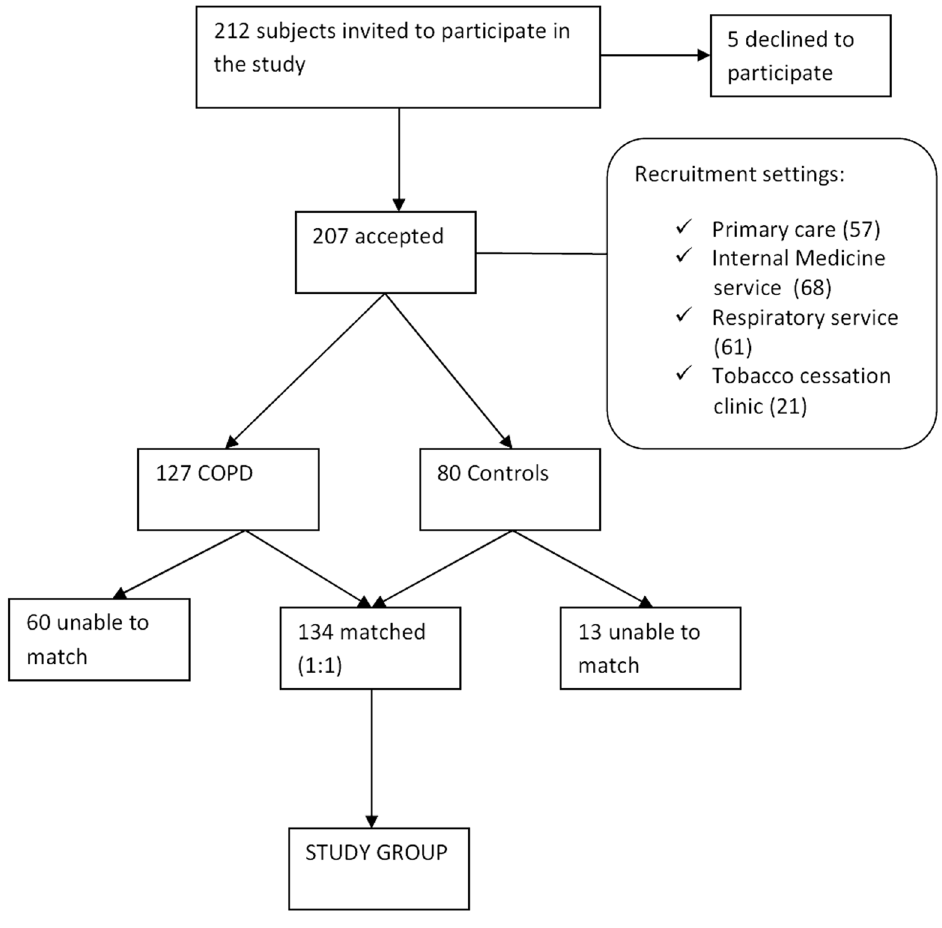
Fig 1. Flow diagram of the